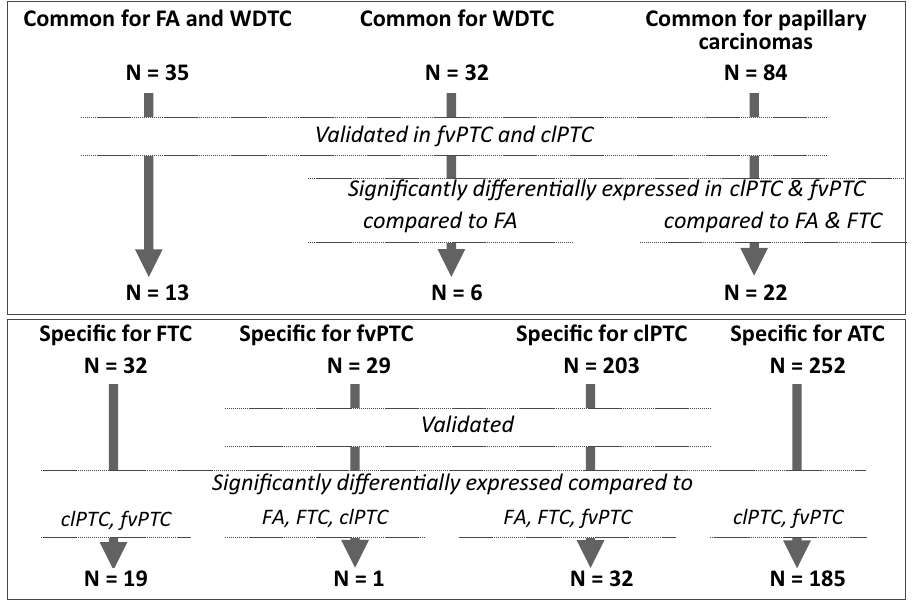
Figure 4. Numbers of common and specific lncRNAs found after intersection analysis and